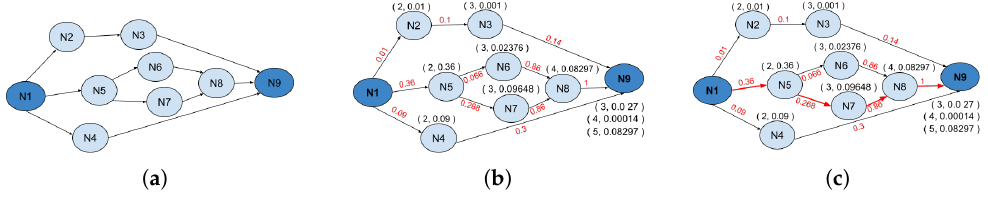
Figure 3. Steps in transition graph of AV example: ( a ) transition graph; ( b ) transition graph with probabilities; ( c ) transition graph with probabilities and best path in red